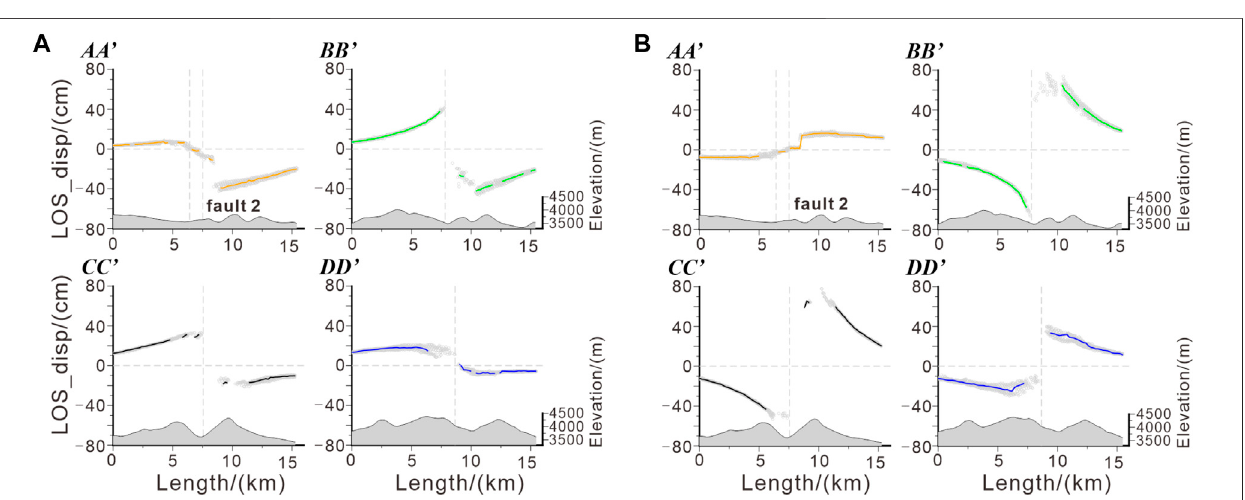
FIGURE3| Co-seismicdisplacementpro fi lesoftheMenyuanMs6.9earthquake(LOSdirection). (A) Cross-faultdisplacementpro fi lesoftheT128ascendingorbit, with pro fi le location shown in Figure 2 ; (B) Cross-fault displacement pro fi les of the T33 descending orbit. Gray circles are the data within 1 km along the pro fi le. The vertical gray dotted line indicates the location of the faults, of which the southern branch fault (fault2) is located about 1 km south from the main fault.